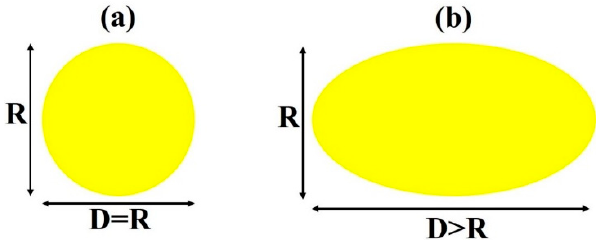
Figure 4. Planar section of an Au/Pd cluster in ( a ) first growth stages (a circle of diameter D) and ( b ) later growth stages (elongated shape represented as an ellipse of characteristic sizes R and D >